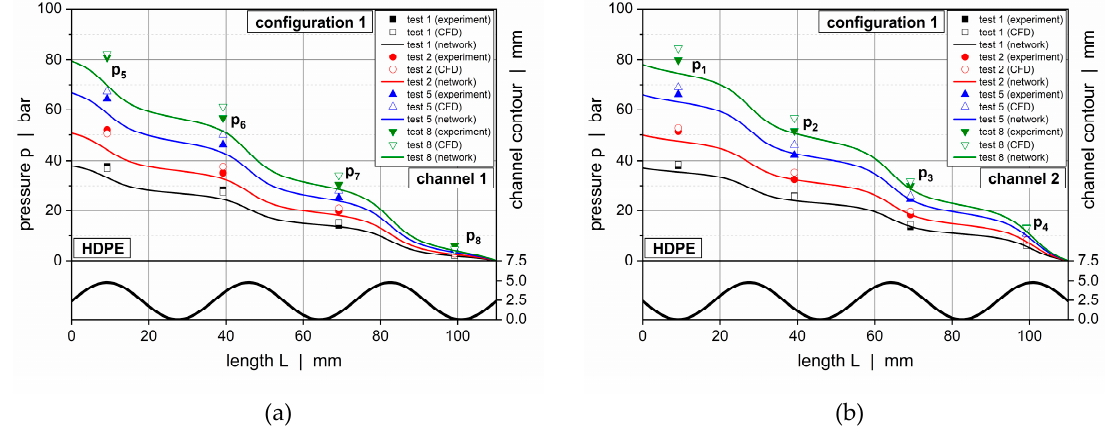
Figure 19. Comparison between experimental data and calculated solutions (seminumerical approach based on network theory vs CFD simulation) for selected operating conditions. Downchannel pressure profiles along channel 1 ( a ) and channel 2 ( b ) for HDPE and configuration 1.